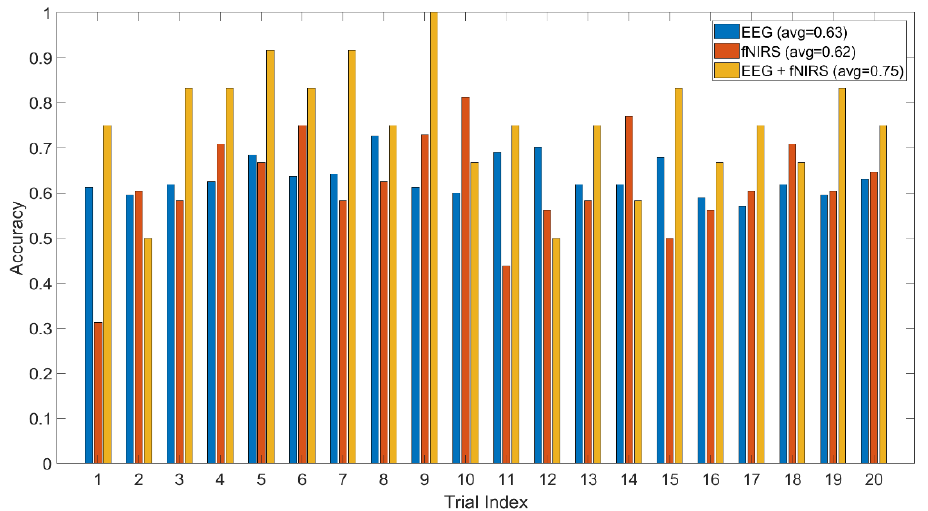
Figure 10. Comparison of the proposed method (EEG + fNIRS) and the ones where only EEG or fNIRS employed for all image-content trials. Table 2. Performance comparisons of the proposed method (EEG + fNIRS) and the ones where only EEG or fNIRS employed for all image-content